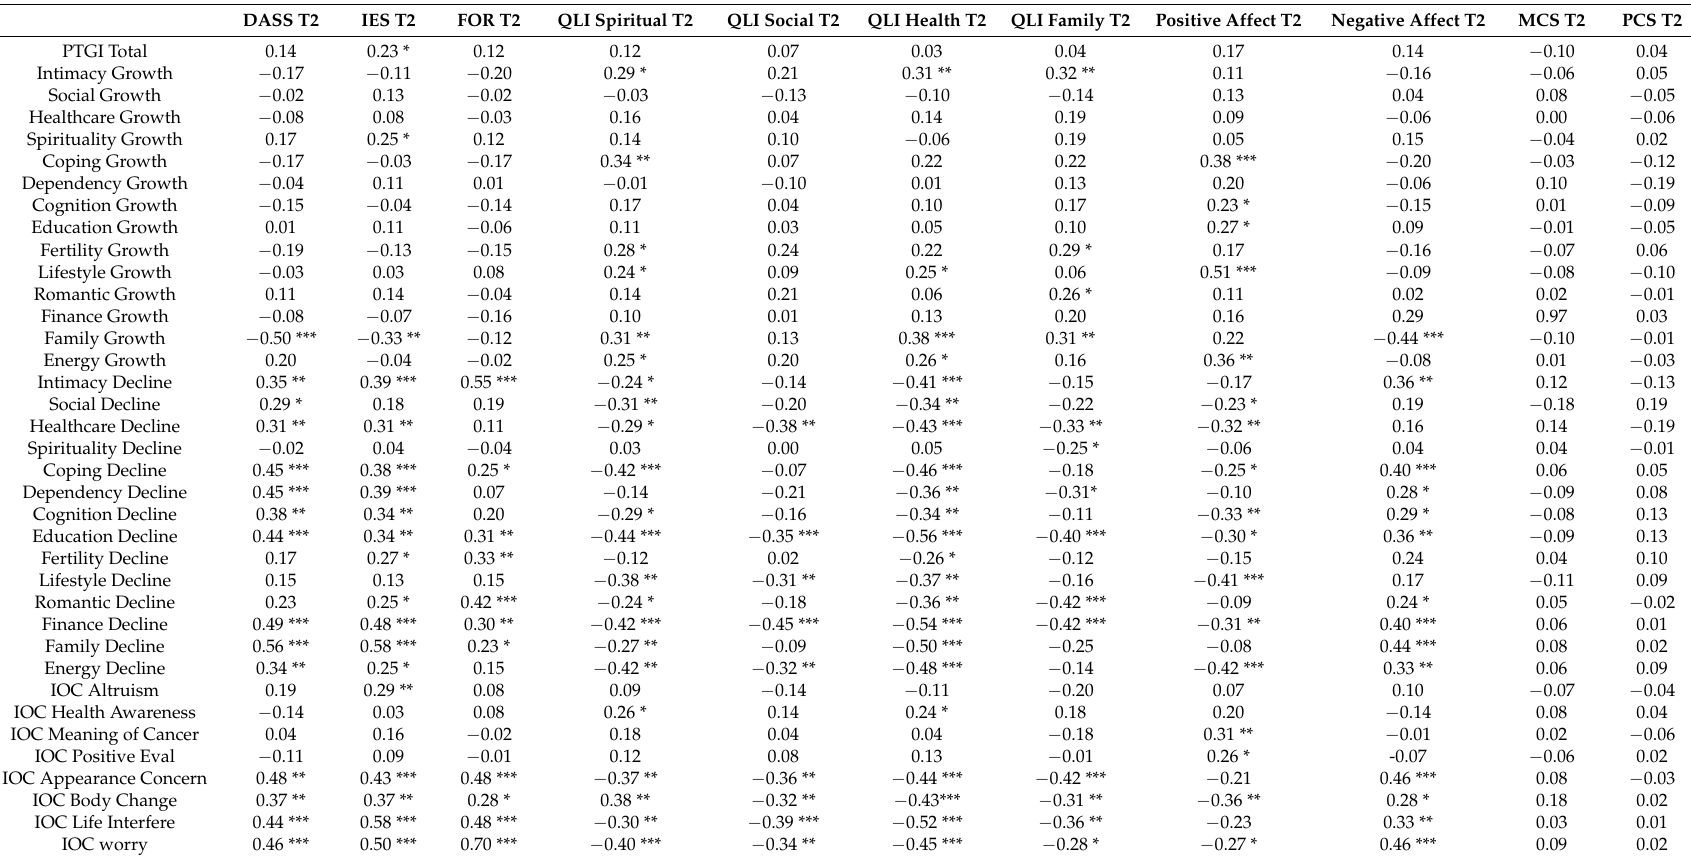
Table 2. Longitudinal Bivariate Correlational Analysis of T1 perceived posttraumatic growth (PPTG) and T2